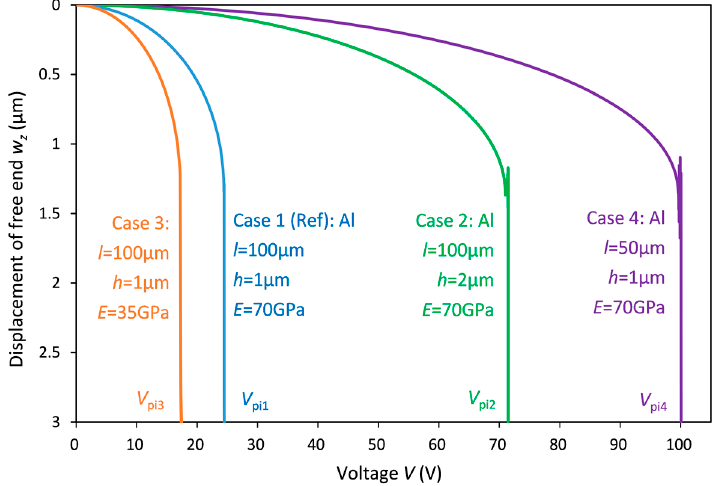
Figure 8. Displacement of the cantilever tip as a function of voltage for different MEMS cantilevers, keeping ρ = 2700 kg/m 3 constant. These colors correspond to the colors in Table 2.